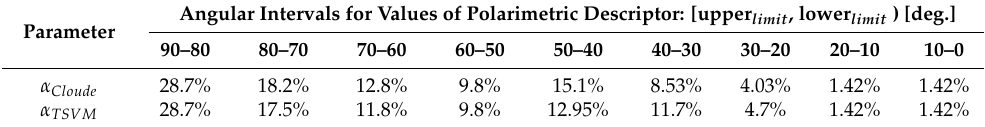
Table 6. 90 ◦ Dihedral. Percentage distribution of estimated values for the angular polarimetric descriptors in intervals of 10 deg., between [0, 90] deg. (for all observation directions in the investigated range). Angular Intervals for Values of Polarimetric Descriptor: [upper limit , lower limit ) [deg.] Parameter